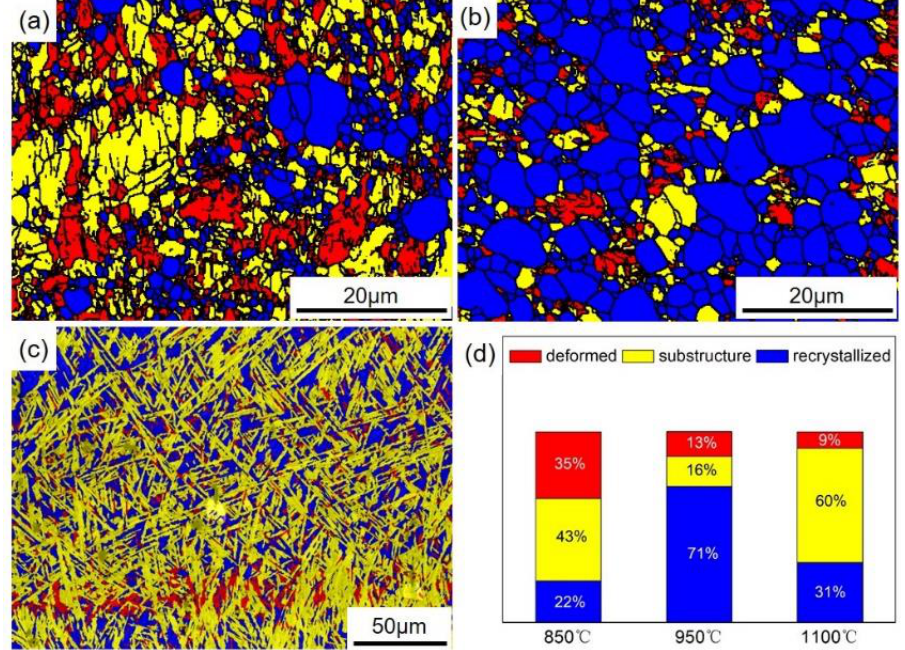
Figure 6. SEM-EBSD recrystallized, substructure, and deformed grains in Ti-6Al-4V alloy deformed by 90% at different temperatures: ( a ) 850 °C, ( b ) 950 °C, ( c ) 1100 °C, ( d ) the proportion.